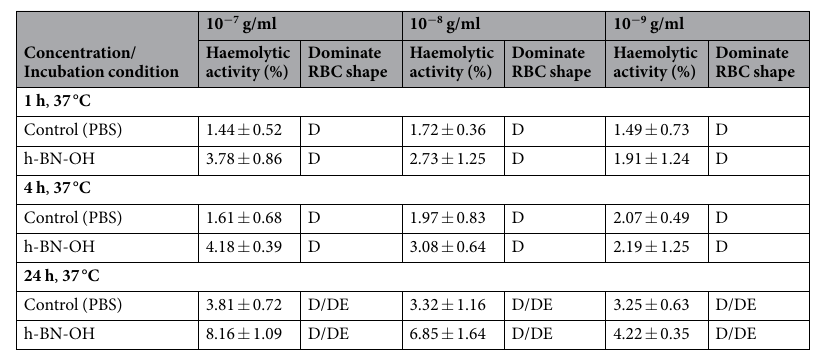
Table 1. The effect of the h-BN-OH nanoflakes on RBCs after different incubation times (1 hour, 4 hours, and 24 hours at 37 °C) at the given concentration. Haemolysis above 5% indicates weak haemolytic activity The presented values are the mean ± SD of three independent experiments with RBCs from different donors; abbreviations: D – discocytes (as control cells), DE –